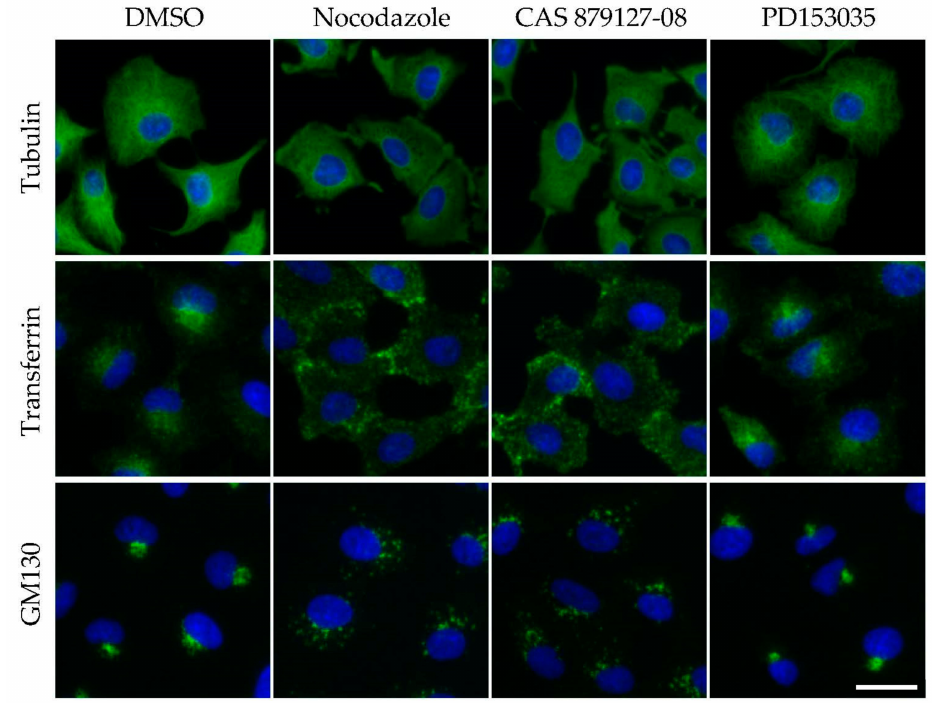
Figure 1. Microtubule depolymerization impairs intracellular trafficking. A549 cells were treated with DMSO (0.1%), nocodazole (1 µ M), CAS 879127-08 (1 µ M), or PD153035 (epidermal growth factor receptor (EGFR) kinase inhibitor, 1 µ M) for 1 h. Cells were fixed and immunofluorescently stained to visualize microtubules using an anti-tubulin antibody (Upper panels, green) or Golgi structures using an anti-GM130 antibody (Middle panels, green). To visualize internalized transferrin, cells were incubated with fluorescently labeled transferrin for 5 min (Bottom panels, green). Cells were counterstained with Hoechst33342 (blue). Scale bar, 20 µ